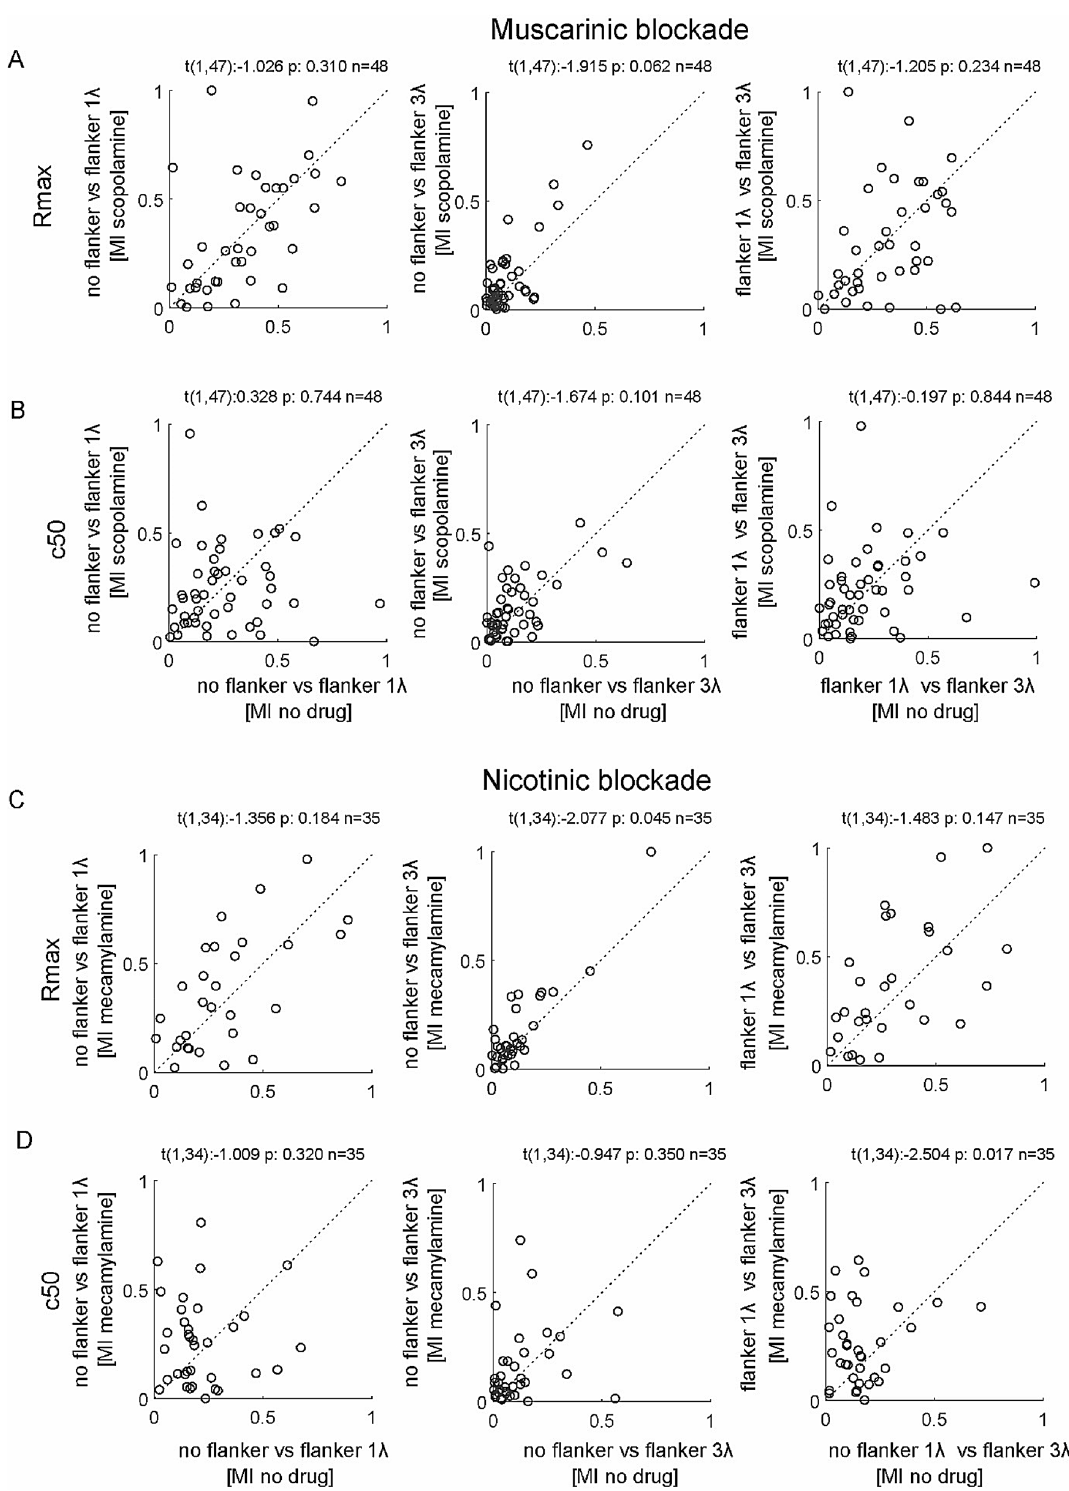
Figure 6. Effect of muscarinic and nicotinic blockade on flanker induced modulations of Rmax and c50. ( A ) Scatterplot of absolute values of modulation indices (MI) for Rmax in the no drug condition (x-axis) against scatterplot of absolute values of modulation indices (MI) for in the scopolamine applied condition (y-axis). Left column shows MIs for the no flanker versus flanker of 1λ condition, middle shows MIs for the no flanker versus flanker of 3λ condition, and right column shows MIs for the flanker of 3λ condition versus flanker of 1λ condition. Insets show paired t-test statistics. ( B ) Same as A but with absolute MIs for c50 values. ( C,D ) same as A and B but with mecamylamine as drug used, instead of